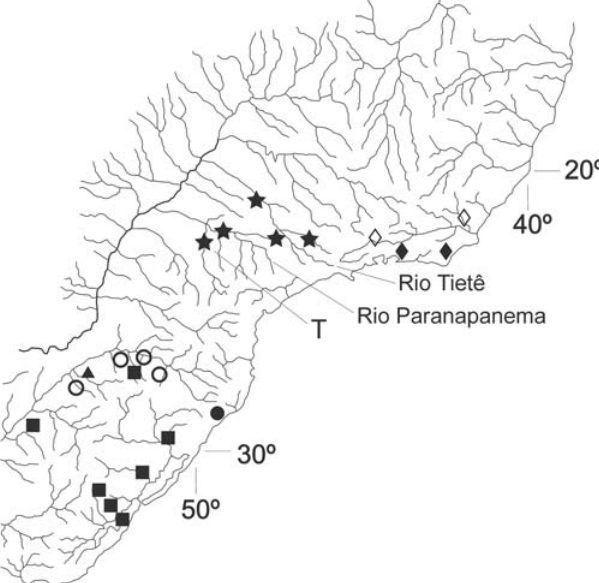
Fig. 3. Left pectoral spine of (A) Microglanis garavelloi (MZUEL 1677), (B) M. parahybae (MNRJ 15989) and (C) M. cottoides (MCP 10826). Scale bar = 1mm. Fig. 4. Partial map of South America showing geographic dis- tribution of southern species of Microglanis . M. cibelae (black circle); M. cottoides (black squares); M. eurystoma (open circles); M. garavelloi (black stars, T = type locality); M. malabarbai (black triangle); M. nigripinnis (black diamont); M. parahybae (open diamont). Each symbol may represent more than one locality or lot (Localities of